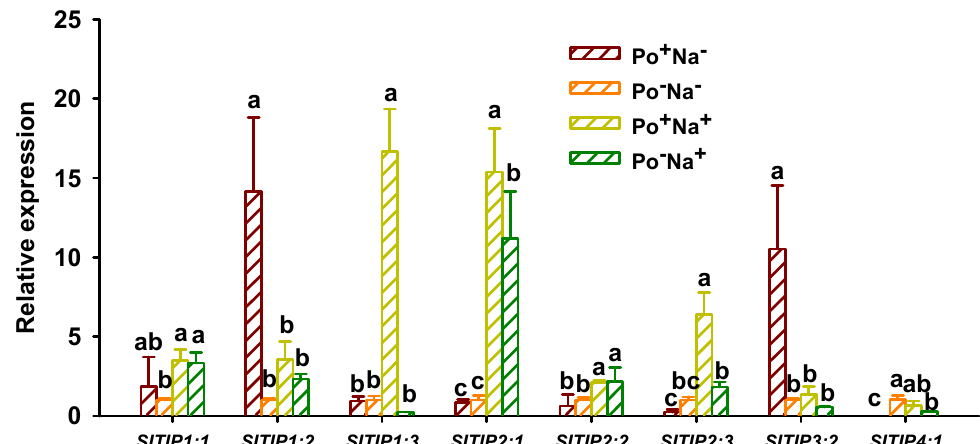
Figure 4. Changes in leaf SlTIP1 and SlTIP2 expressions of tomato plants colonized by Paraglomus occultum under 0 and 150 mM NaCl stress. Data (means ± SD, n = 3) followed by different letters on the bar indicate significant differences among treatments at the 0.05 level. See Table 1 for abbreviations.